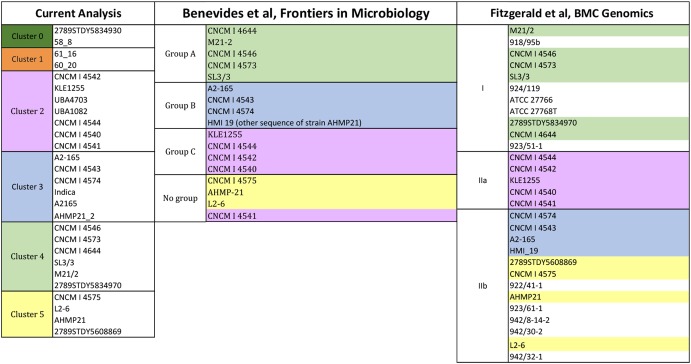
Clustering of strains activities having F. prausnitzii SL3-3 (fpa) as reference. The reference strains are located in cluster 4. Strain per cluster: cluster 0 (58_8, 2789STDY5834930), in cluster 1 (60_20 and 61_16), in cluster 2 (UBA4703, UBA1080, CNCM | 4544, KLE1255, CNCM | 4542, CNCM | 4540, and CNCM | 4541), in cluster 3 (A2-165, Indica, CNCM | 4574, A2165, CNCM | 4543, and AHMP21-2), in cluster 4 (M21/2, CNCM | 4573, 2789STDY5834970, SL3/3, CNCM | 4546, and CNCM | 4644), and in cluster 5 (CNCM | 4575, L2-6, AHMP21, and 2789STDY5608869).